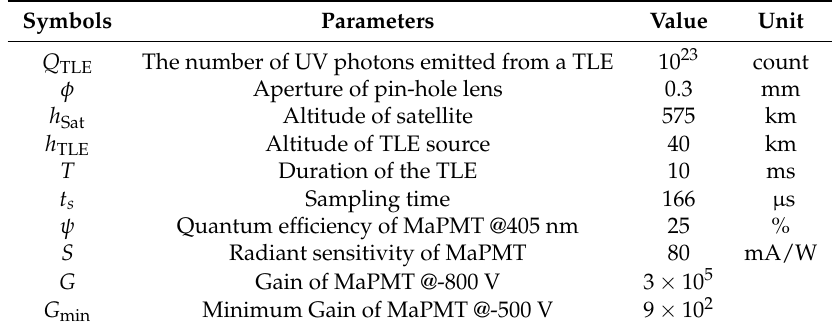
Figure 10. Detection of TLEs near the Earth’s horizon. The line of sight angle to the TLE is computed as 67.3 ◦ by simple trigonometry, which is within the observation range of the TLE observation system. The distance to the TLE is then denoted by D limb . Table 3. The parameters for calculation of electric charge produced by TLE emission in space. Symbols Parameters